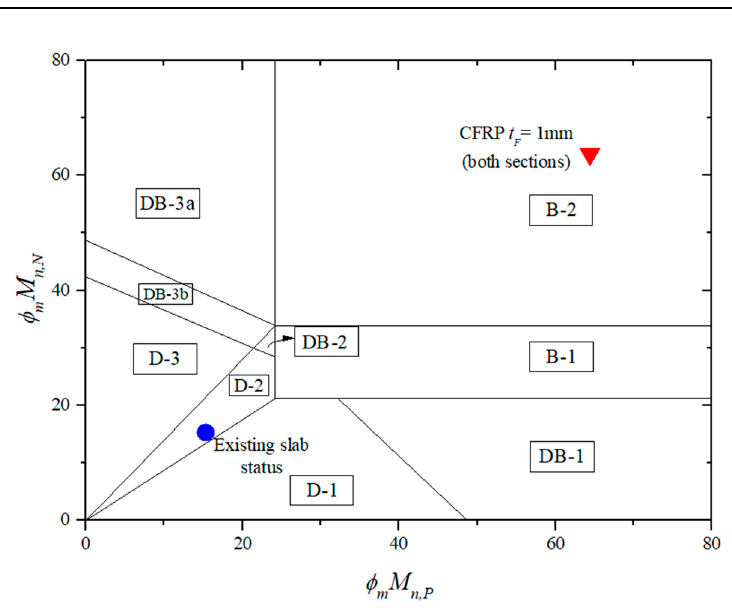
Figure 6. Failure limits for the flexural strengthened slab with CFRP.